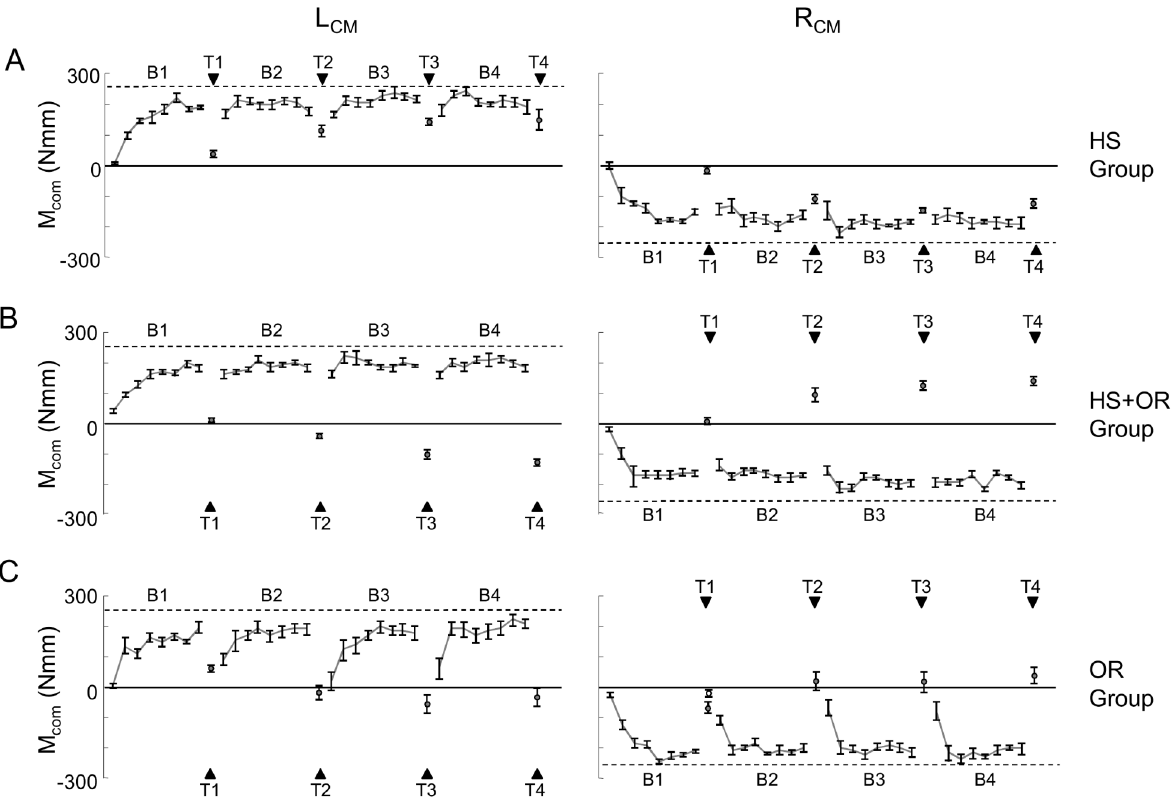
Figure 3. Compensatory moment across all trials. The relative compensatory moment (M com ) is shown as a function of trial for each block of consecutive trials and transfer trials (T1 through T4). Data are separated for three groups and two blocked task CM conditions. Dashed horizontal lines denote the magnitude of M com that the subjects should generate at object lift onset to neutralize the external moment during each block of consecutive trials. Black triangles denote M com that subject should exert on the transfer trial. Data are averages of all subjects and vertical bars denote standard errors of the mean. The left and right columns represent L CM and R CM conditions, respectively. The top, middle, and bottom rows represent HS, HS + OR, and OR groups, respectively.